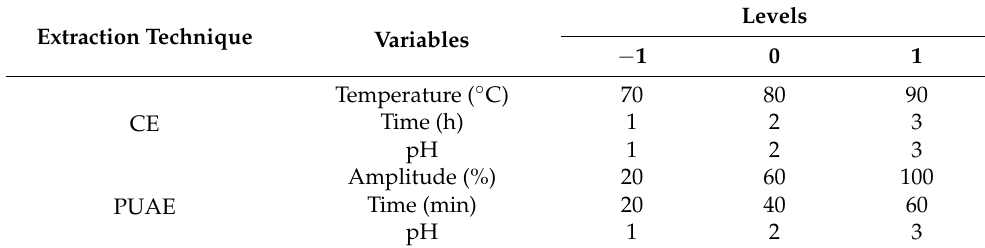
Table 1. Variables and levels used for Box–Behnken